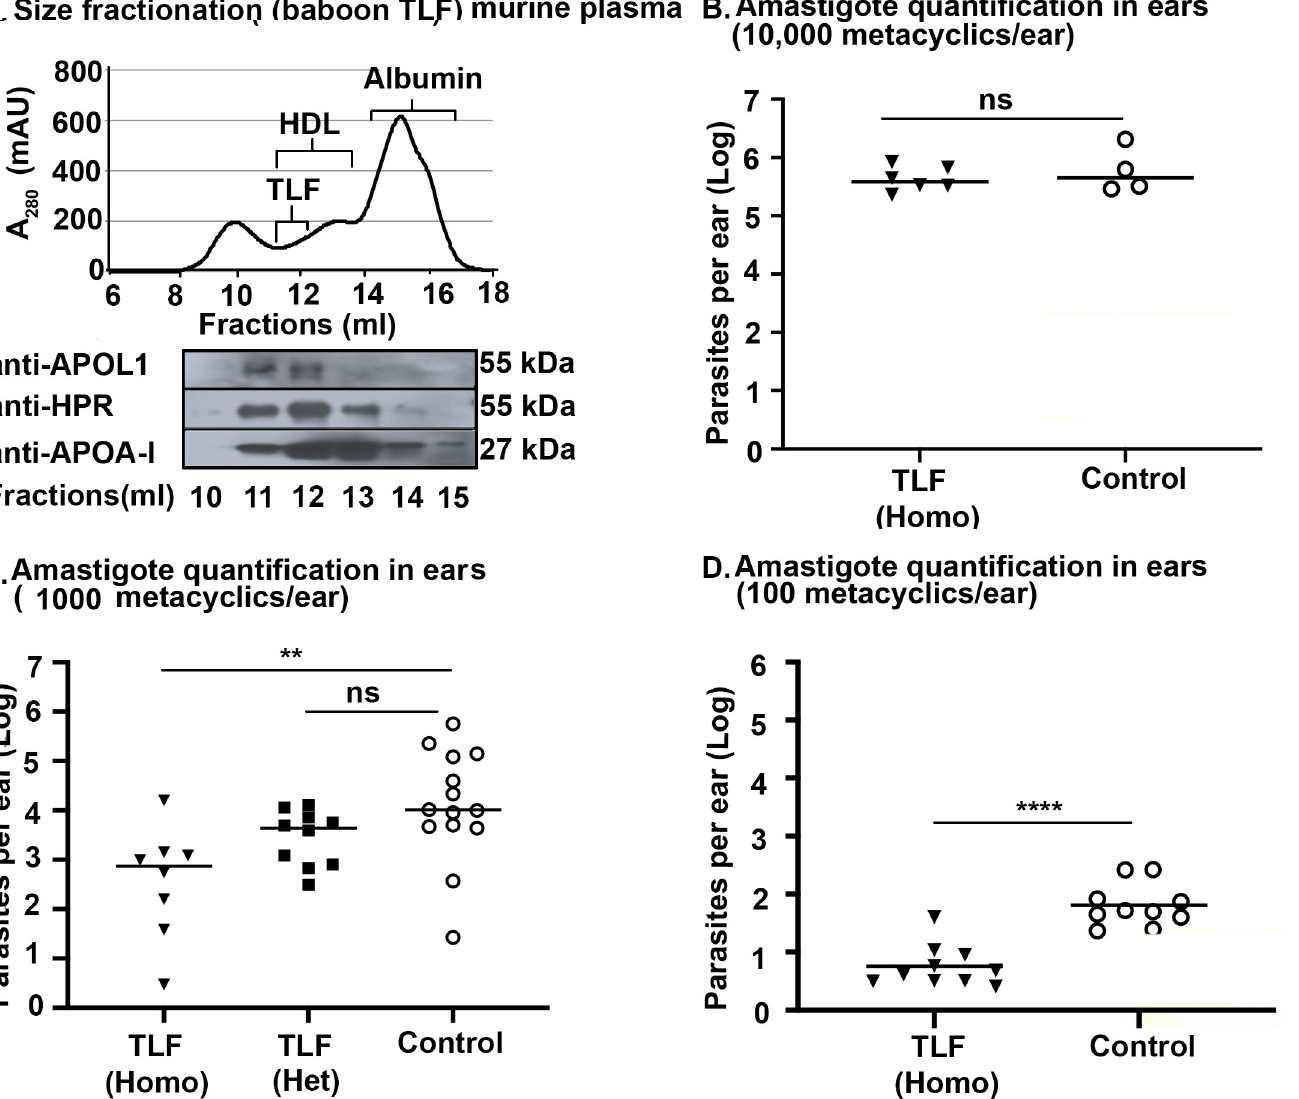
Fig 2. Germline targeted transgenic mice expressing baboon TLF ameliorate intradermal infection by L . major . A. Plasma from germline transgenic mice expressing baboon APOL1 and HPR separated by size exclusion chromatography showing the protein absorbance profile (280 nm) and the western blot of the fractions (10–15) for three TLF proteins- APOL1, HPR and APOA-I. Fractions 11–14 contain HDL. B–D. Number of parasites in germline transgenic mice ears (Homo = homozygotes, Het = Heterozygotes) quantified by real-time PCR 15 days post-infection with: B. 10,000 metacyclic promastigotes n = 3 mice, 6 ears (TLF), n = 2 mice, 4 ears (control). C. 1000 metacyclic promastigotes, n = 4 mice, 8 ears (Homo), 5 mice, 10 ears (Het), 7 mice, 14 ears (Control). D. 100 metacyclic promastigotes, n = 5 mice, 10 ears per group. The data represents Mean ± SD of one typical experiment that has been repeated three times. �� p < 0.001, ���� p < 0.0001 and ns- non-significant, Mann-Whitney U test (Fig 2B and 2D) and ANOVA multiple comparisons with Bonferroni correction (Fig 2C) were used for statistical